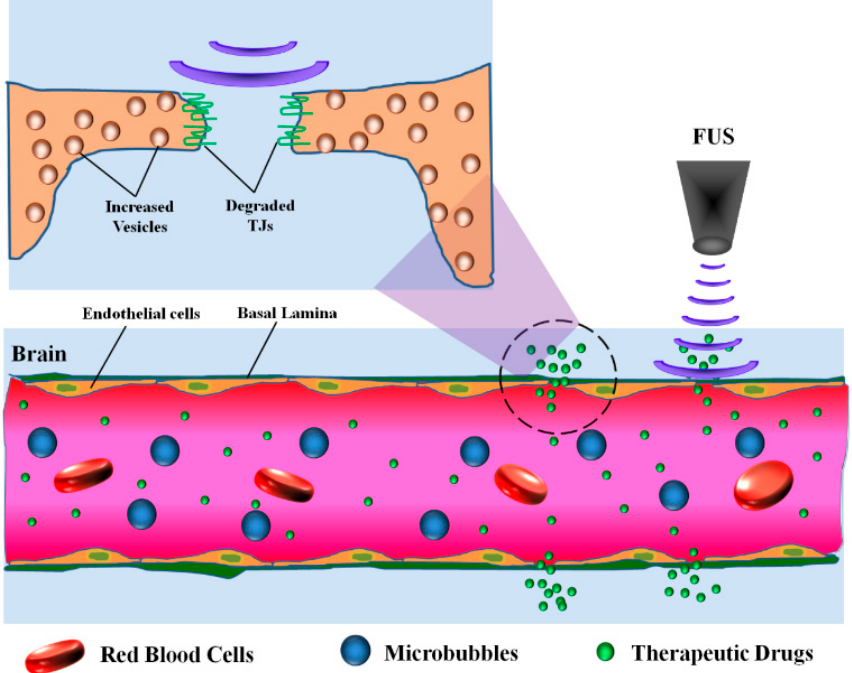
Figure 3. Schematic of BBB disruption by focused ultrasound (FUS) and drug uptake into disrupted regions. Inset indicates that when microbubbles apply mechanical forces on endothelial cells, tight junctions can open and there can be increased transport vesicle formation.